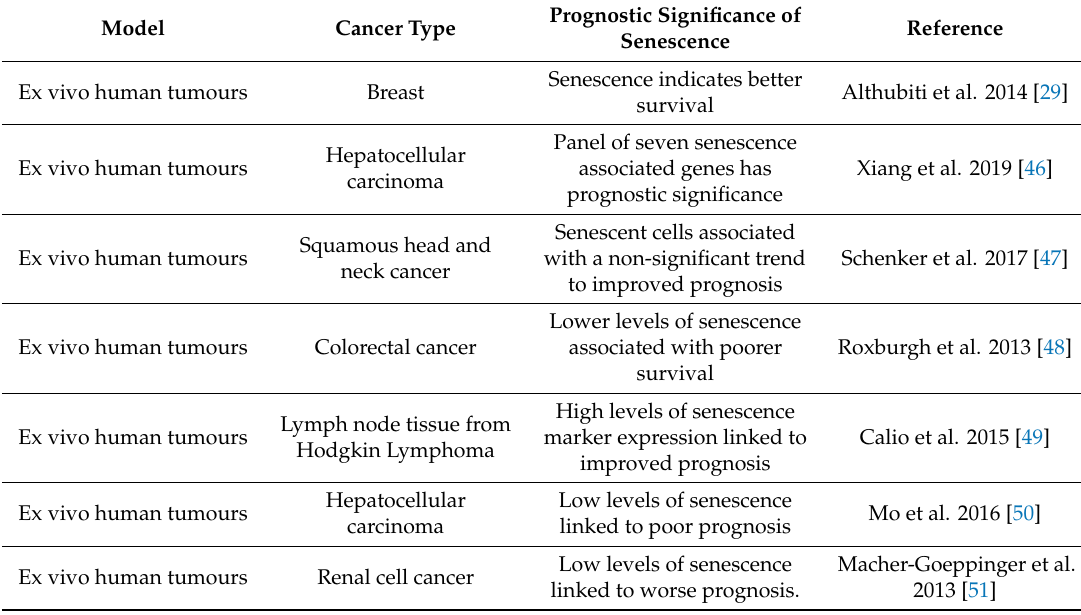
Table 2. Table summarising studies of senescence as a prognostic biomarker in various types of